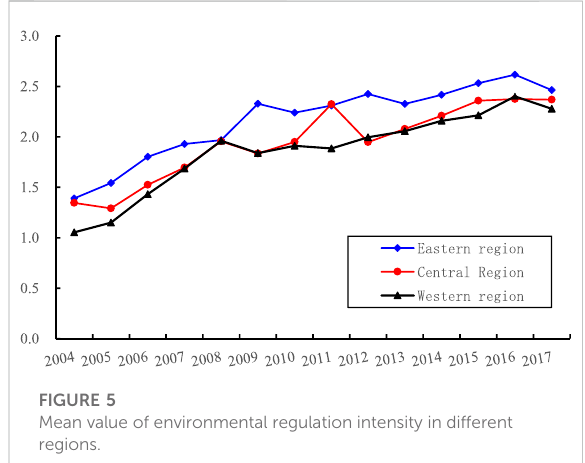
FIGURE 5 Mean value of environmental regulation intensity in different